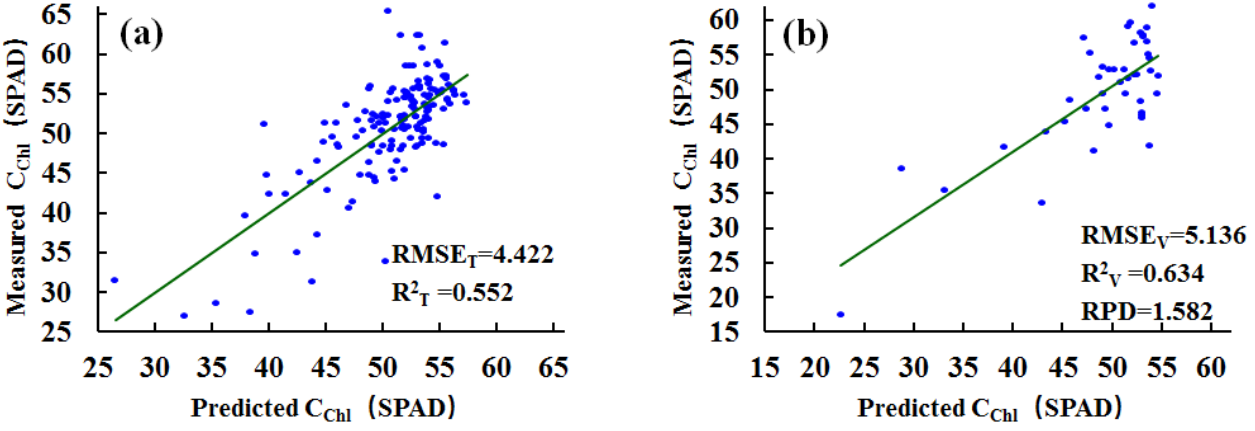
Figure 7. The estimated results of SPAD value for ( a ) training set and ( b ) validation set at milk